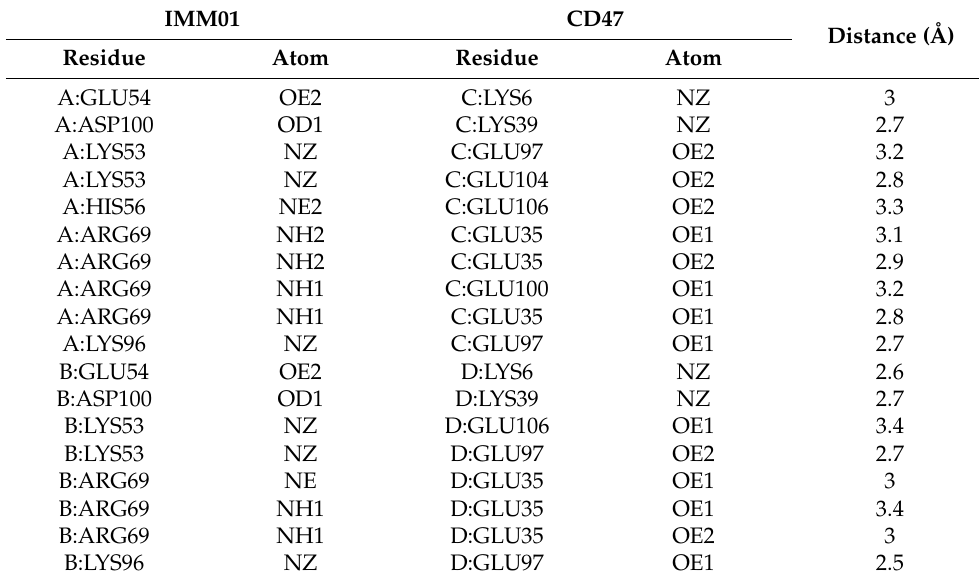
Table 2: Comparing IMM01/CD47 structure with the structure in the literature (PDB ID 2JJT), the salt bridge interactions are very similar, except the salt bridge bond between LYS53 in IMM01 and GLU106 in CD47, which only occurs between the B and D chains. However, as the side chain conformation of LYS53 in chain A is slightly different, the salt bridge bond is absent between the A and C chains. At this site between chain A and chain C, there are a salt bridge bond between LYS53 (A) and GLU104 (C) and a salt bridge bond between HIS56 (A) and GLU106 (C) instead. These common salt bridges are chain A:C and chain B:D. According to the sequence alignment results of SIRP α , SIRP β and SIRP γ in the literature (PDB ID 2JJT), except ASP100, the amino acids that form salt bridge bonds are all conserved. Table 2. Salt bridge bonds between IMM01 and CD47.